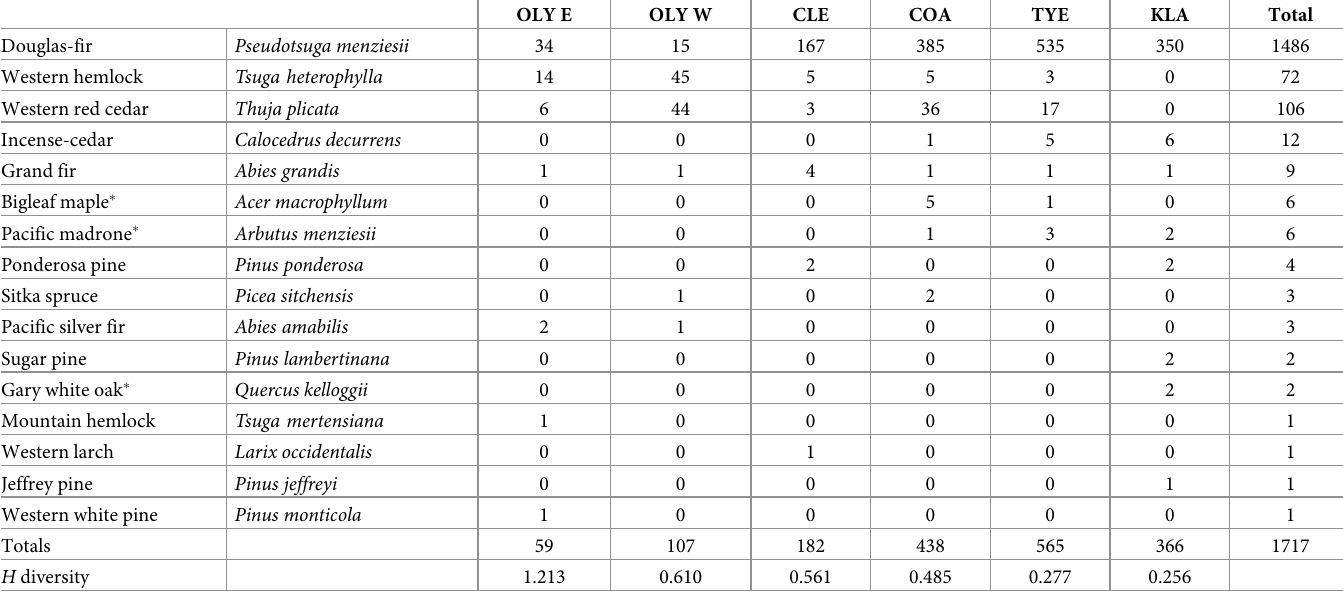
Table 1. Species and number of nest trees of northern spotted owls in Washington and Oregon, USA, subdivided by study area or